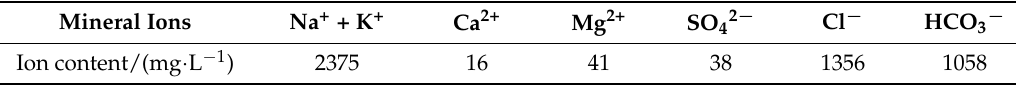
Table 2. Mineral ion content of synthetic